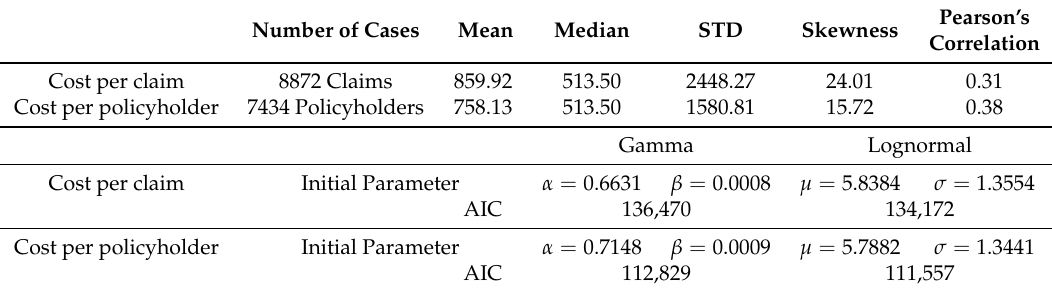
Table 2. Descriptive statistics of cost variables. At the bottom: MLE parameters of Gamma and Lognormal distributions